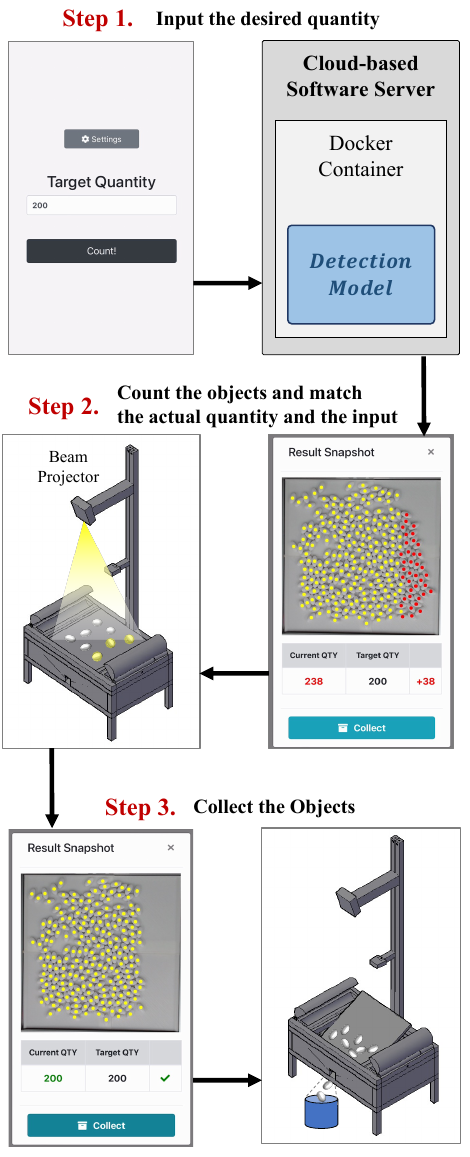
Figure 8. The overall process of the proposed